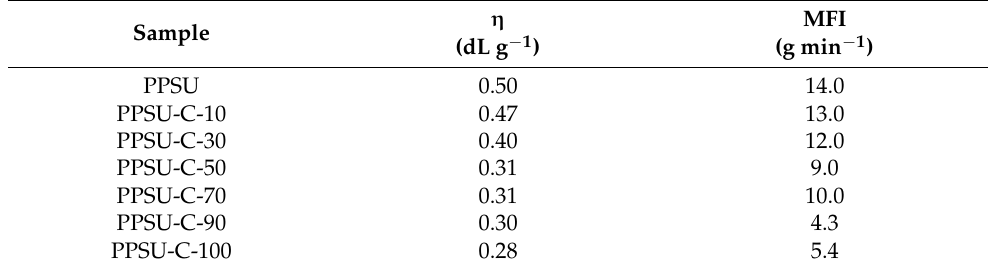
Table 1. Rheological properties.